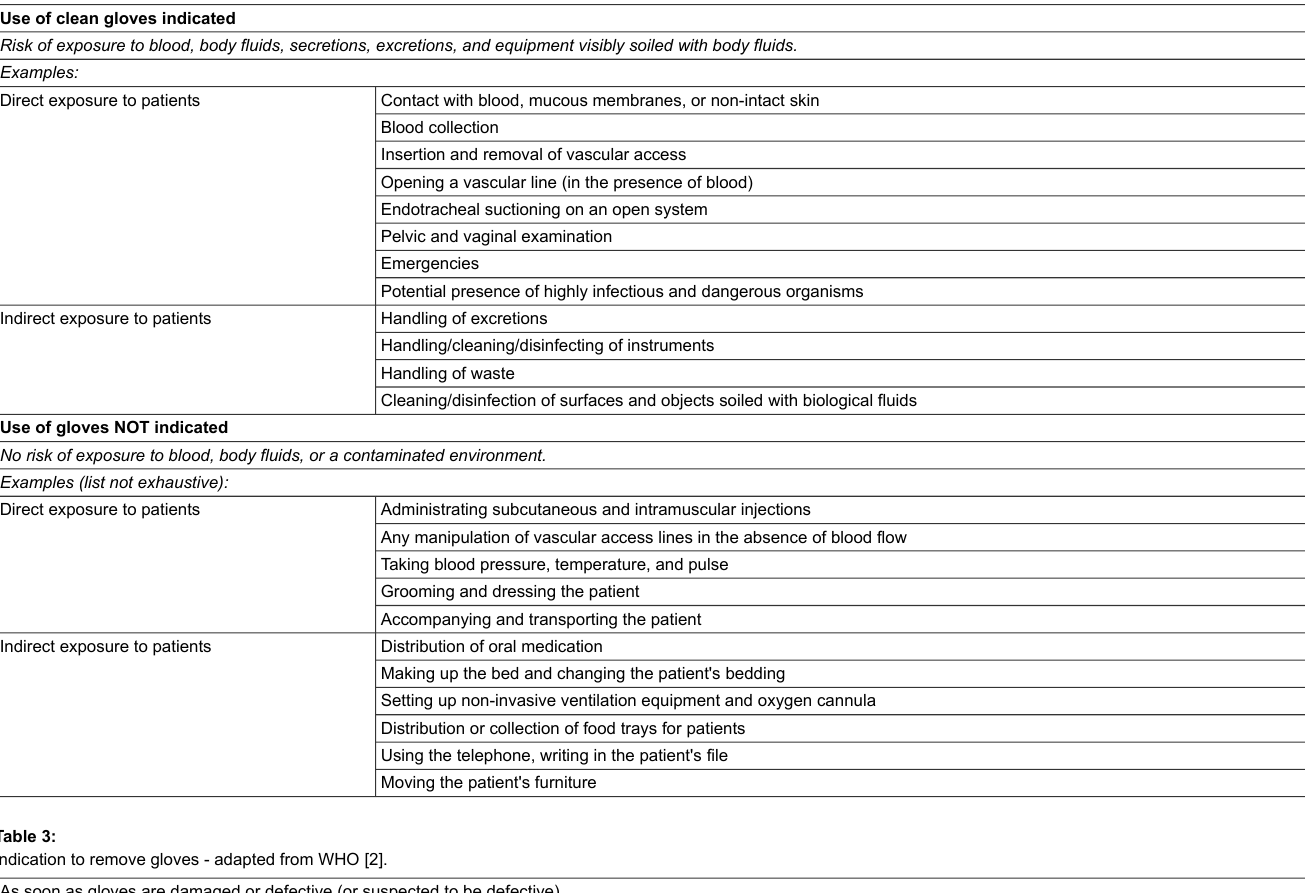
Table 3: Indication to remove gloves - adapted from WHO [2]. As soon as gloves are damaged or defective (or suspected to be defective) Immediately after contact with blood, other body fluids, injured skin, or mucous membranes Immediately after contact with a contaminated patient or body site and the immediate environment When there is an indication for hand